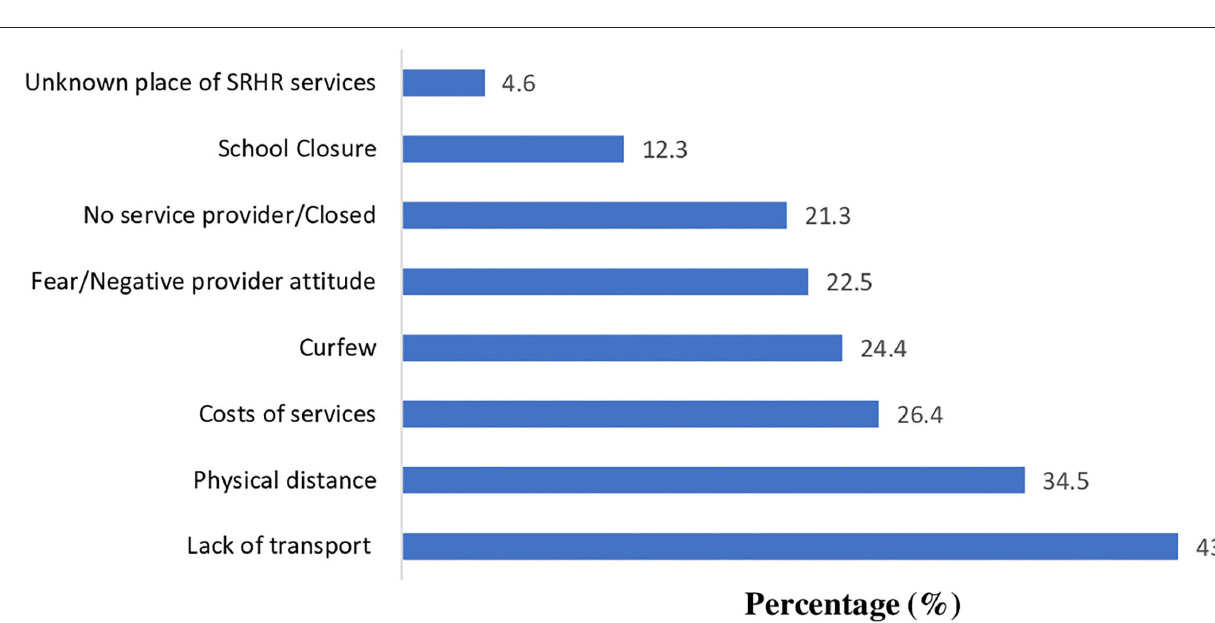
partially lifted for pregnant women and people with